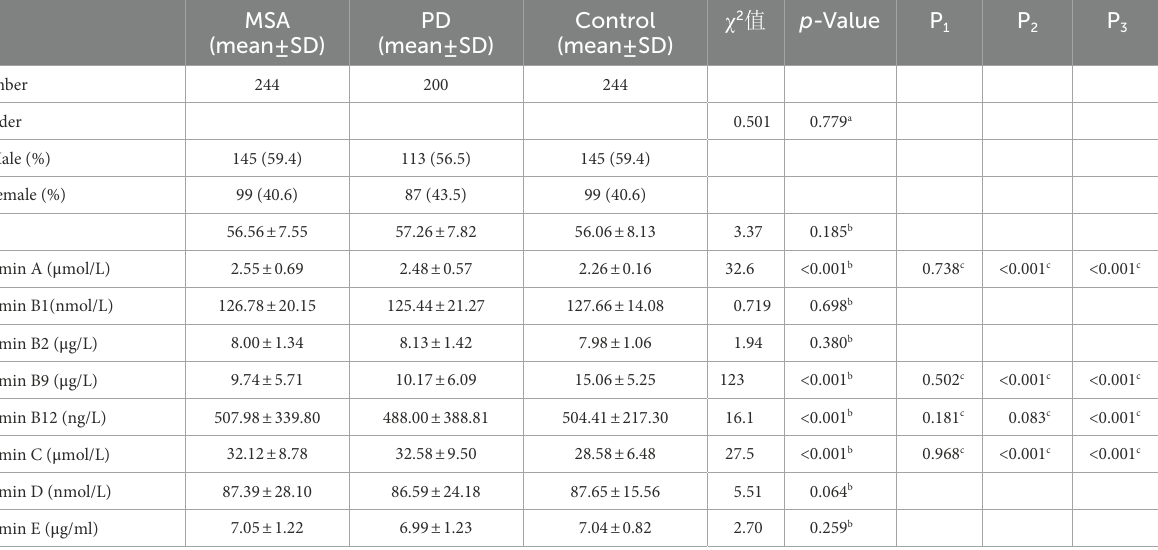
TABLE 1 Characteristics of the three participant